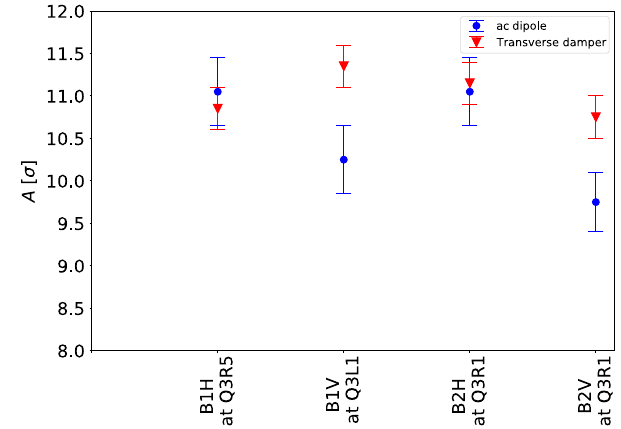
FIG. 13. Comparison of the ac dipole and transverse damper measured apertures for beam 1 and beam 2 in both planes from the 2017 campaign at top energy with colliding beam optics ( β (cid:2) ¼ 30 cm).